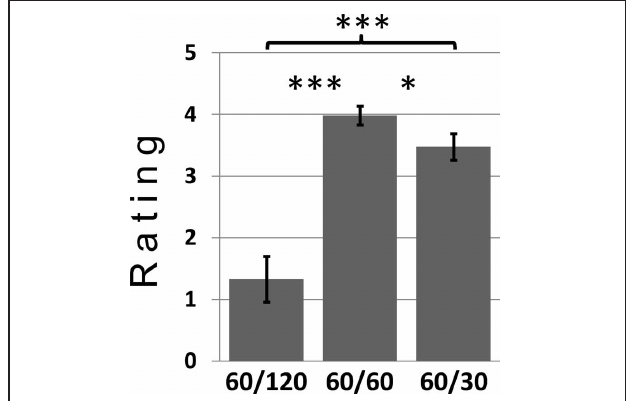
FIGURE 3 | Mean pleasantness ratings for the conditions DI (own income/other’s income: 60/120), E (60/60), and AI (60/30). Error bars indicate the standard error of the mean (SEM). ∗ p < 0 . 05, ∗∗∗ p < 0 . 001 (dependent samples t -tests).